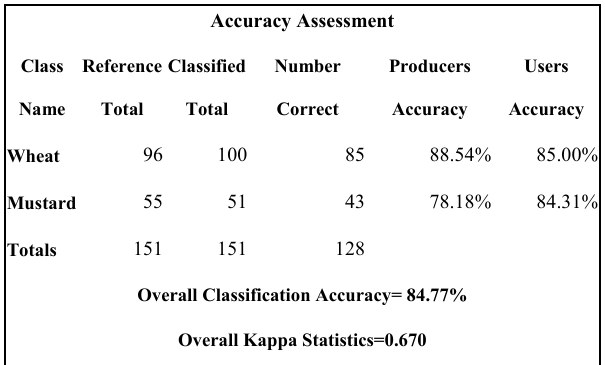
Figure 8. State-wise RMSE (%) between DES & FASAL State level Estimates